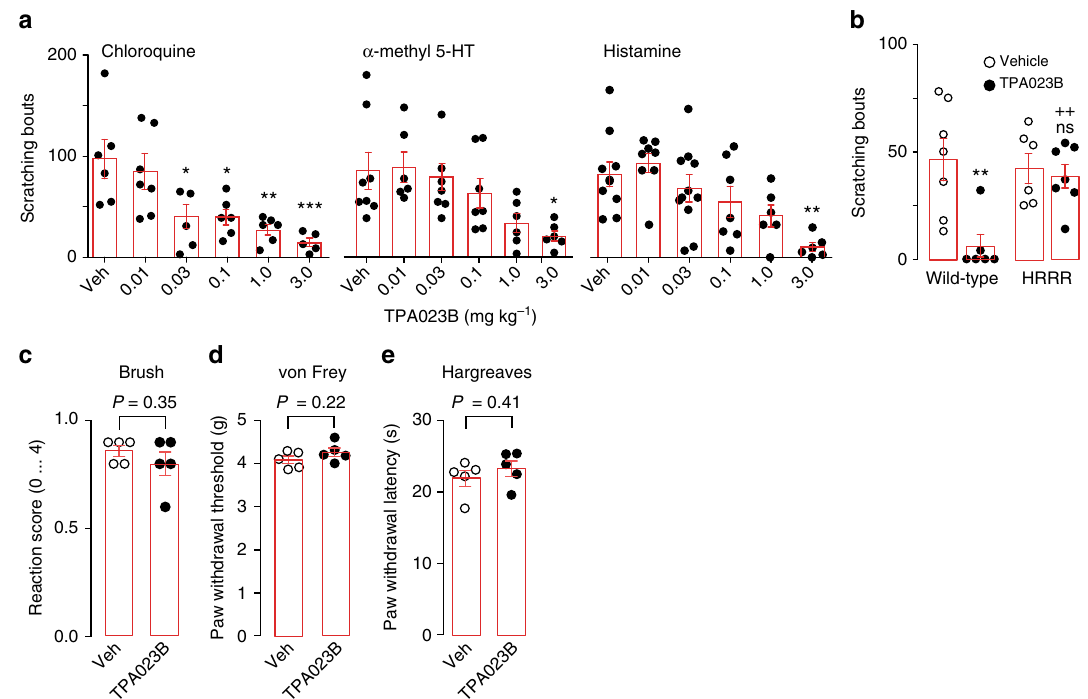
Fig. 6 Antipruritic actions of TPA023B. a Antipruritic actions of TPA023B (p.o.) in mouse models of acute itch. Circles are total number of scratching bouts observed in individual mice within 30 min after intracutaneuos pruritogen injection. ANOVA, followed Dunnett ’ s post hoc test with vehicle as control. * P < 0.05, ** P < 0.01, *** P < 0.001. Chloroquine (100 µ g). F(5,29) = 6.44, n = 6, 7, 6, 6, 6, 5 for vehicle, and 0.01, 0.03, 0.1, 1.0, and 3.0 mg kg − 1 . α -Me5HT- evoked itch (20 µ g). n = 8, 6, 7, 7, 6, 6 for vehicle, and 0.01, 0.03, 0.1, 1.0, and 3.0 mg kg − 1 . Histamine-evoked itch (100 µ g). F(5,41) = 5.20, n = 9, 8, 11, 7, 6, 6 for vehicle, and 0.01, 0.03, 0.1, 1.0, and 3.0 mg kg − 1 . b The antipruritic action of TPA023B occurs via the benzodiazepine bind site of GABA A Rs. α - methyl 5-HT (20 µ g) was injected intracutaneously into the right cheek. TPA023B (1 mg kg − 1 , p.o.) exerted strong antipruritic actions in wild-type mice. In HRRR mice, in which all TPA023B sensitive GABA A Rs subtypes had been rendered benzodiazepine-insensitive, TPA023B had completely lost its antipruritic action. Two-way ANOVA F(2,22) = 6.45. P = 0.019 for genotype× treatment. P = 0.005 (**) and 0.60 (ns) for treatment effect in wild-type and HRRR mice, respectively ( n = 7, 6 (wild-type, vehicle and TPA023B); n = 6, 7 (HRRR mice, vehicle and TPA023B)). ++ P < 0.01 relative to TPA023B- treated wild-type mice. c – e TPA023B (3 mg kg − 1 , p.o.) did not interfere with responses to somatosensory or acute noxious stimulation. c light mechanical stimulation with a paint brush, d punctate mechanical stimulation with von Frey fi laments, e noxious heat stimulation with a radiant heat source. Five mice per group. Error bars indicate